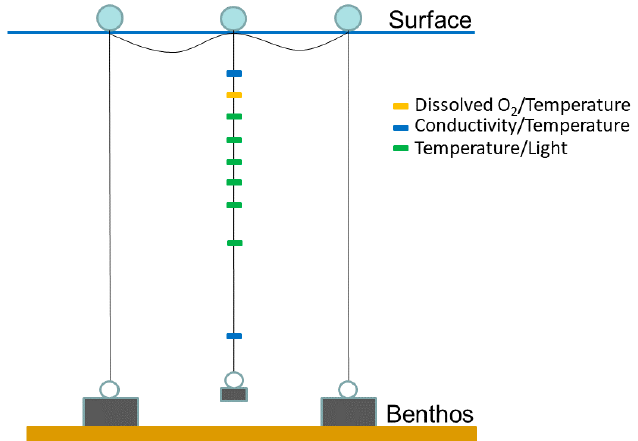
Scheme 1. In situ continuous monitoring instrument chains in pit lakes. Light blue circles are buoys, dark rectangles and white circles are weights. (N.b., number of temperature sensors varied depending on chain